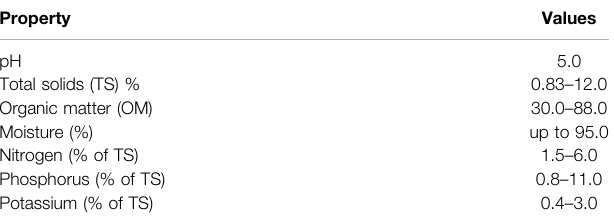
TABLE 2 | Physicochemical properties of SS (Pedersen, 1981; Metcalf and Eddy, 1995; Rulkens, 2008).